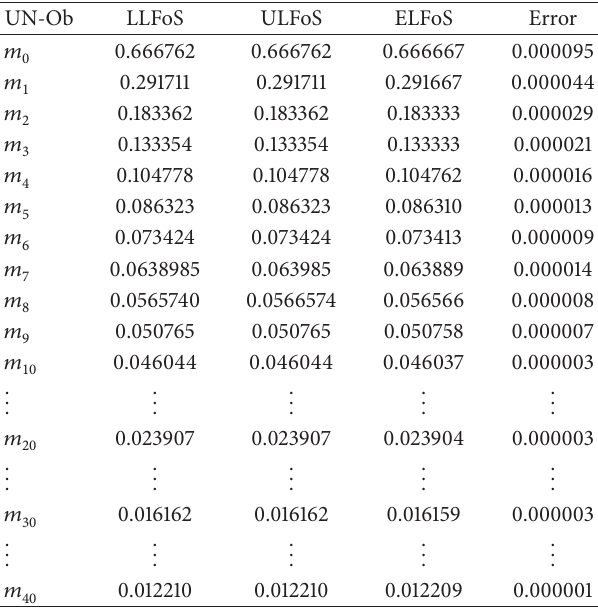
Table 2: Upper and lower bounds for Example 1 for 𝑁 = 50 .